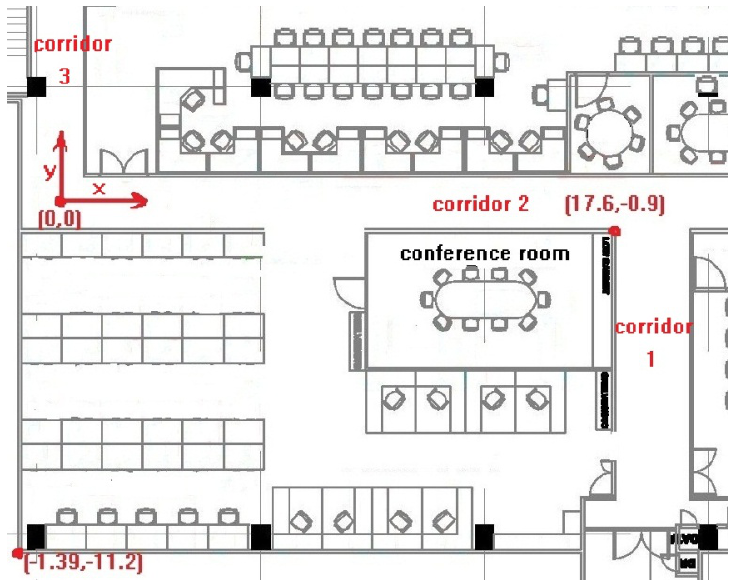
Figure 2. Experimental testbed with walls and